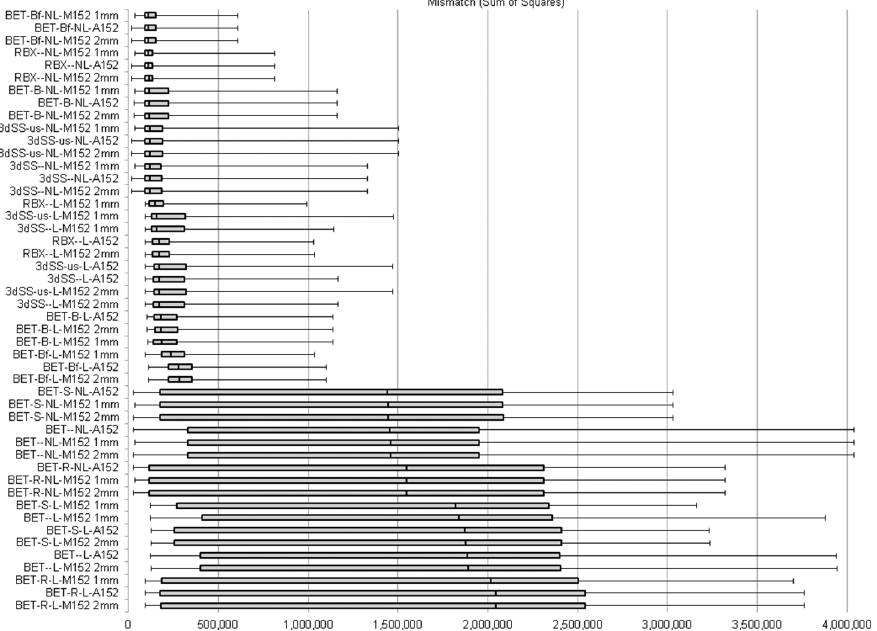
The second discontinuity in the mismatch ranking appears to be related to the choice of transformation (i.e., linear versus non-linear) employed to project the initial approximate extraction into MNI template space (i.e., step ii). Indeed, for any combination of algorithm and options used in step i, the pipeline featuring linear and non-linear transformations was always superior to the pipeline employing the same step i configuration but followed by a linear transformation only. As showed in Table 1, the first switch from linear plus non-linear to linear transformation only is marked by an increase in sum of squares of approximately